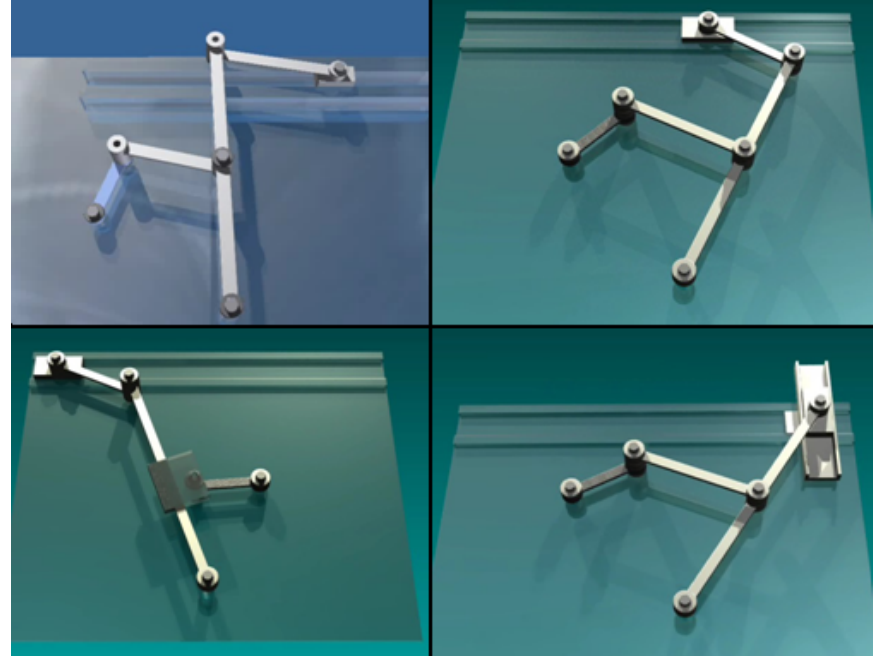
Fig. 3. Models for the virtual laboratory works on the "Theory of mechanisms and machines"